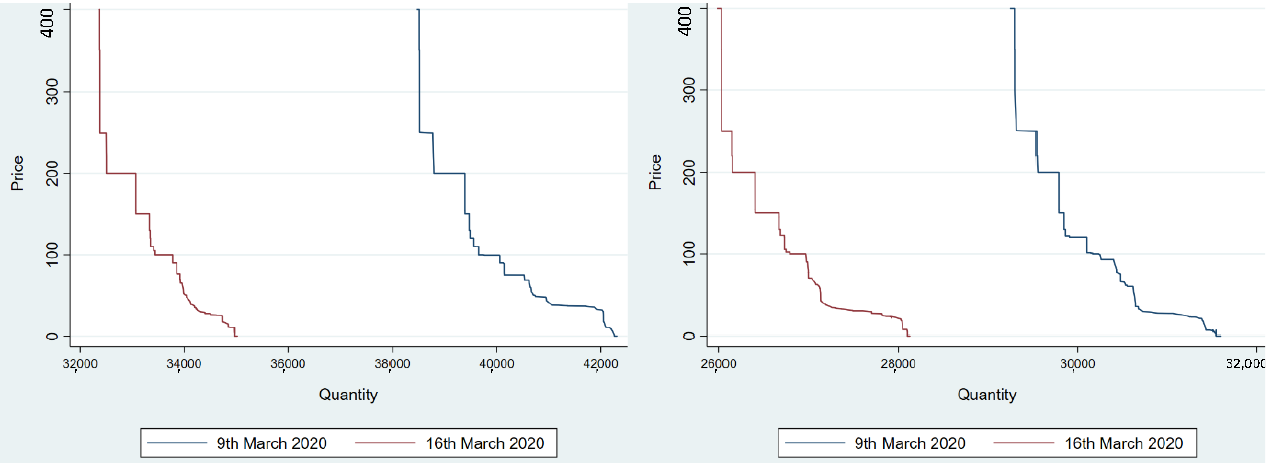
Figure 3. Empirical Demands in the DAM. 9 March and 16 March 2020. Hour: 12 a.m. and 12 p.m. Figure on the left represents the two aggregated demands recorded at 12 a.m. Figure on the right represents the two aggregated demands recorded at 12 p.m.